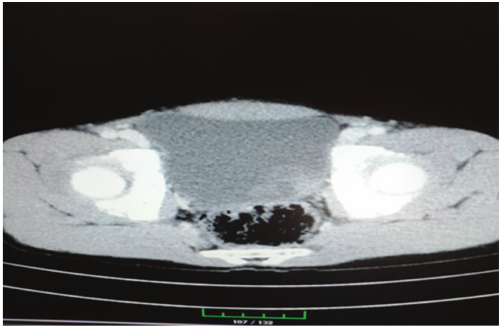
Figure 1: On contrasted CT, a suspicious lesion with thin septa was observed at posterolateral wall of bladder (3.5 × 3 cm in size).